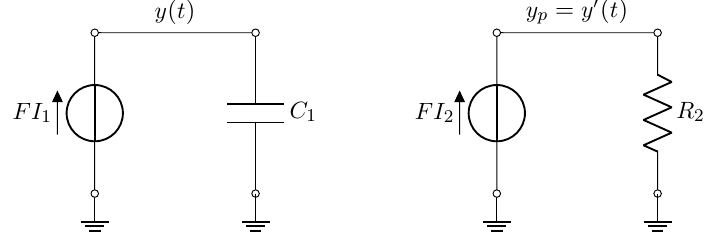
Figure 7. Circuit equivalent with a = 1.